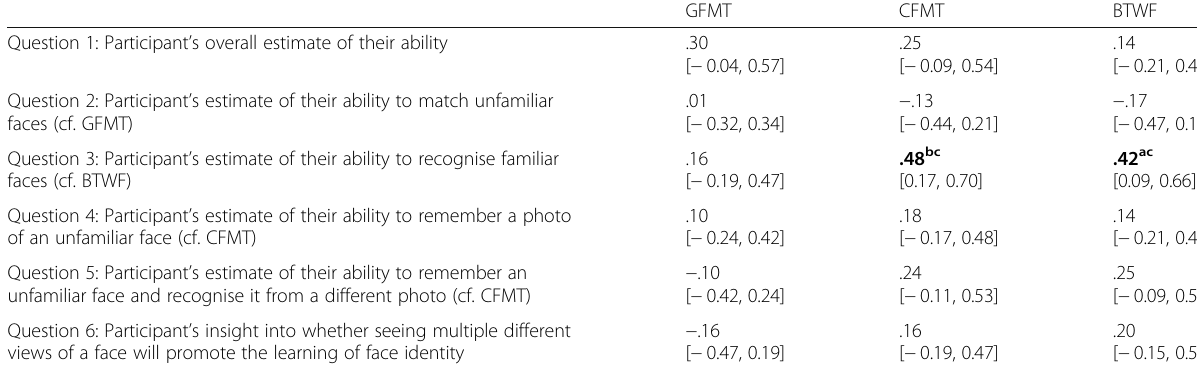
Table 1 Correlations between Questionnaire items (see ‘ Methods ’ for exact wording of each question) and face identity measures (Glasgow Face Matching Test, GFMT; Cambridge Face Memory Test, CFMT; Before They Were Famous task, BTWF) from Study 1. Uncorrected significant correlations are shown in bold: a p < .05, b p < .01; c Significant correlations following Benjamini-Hochberg correction; 95% CI shown in